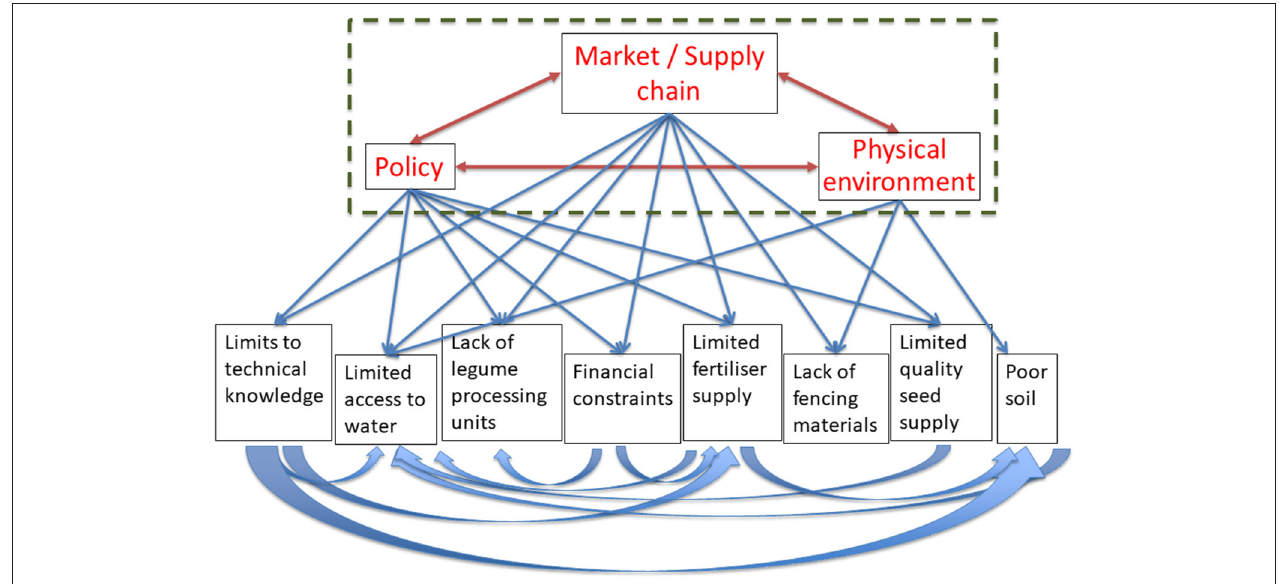
FIGURE 2 | The integrated barriers to pulse production. The key barriers (the eight boxes at the base of the figure) all derive from one or more aspects of the wider food system–in this figure is divided into: Market/supply chain; Physical Environment; and Policy. The links from the core system to the barriers are demonstrated using straight arrows. The barriers also have multiple interacting elements themselves, identified through the curved arrows at the base of the figure. For example, overcoming technical knowledge gaps can help address limited access to water through changing agronomic practices such as plowing and planting date; it is important for soil fertility through guiding methods to increase soil structure; and to limited fertilizer supply through guiding farmers about the appropriate fertilizers required, and the N fixing potential of pulses. These interactions are described in the text. Overall the results demonstrate the importance of looking at the system as a whole—addressing just one aspect will not successfully generate an increase in appropriate pulse